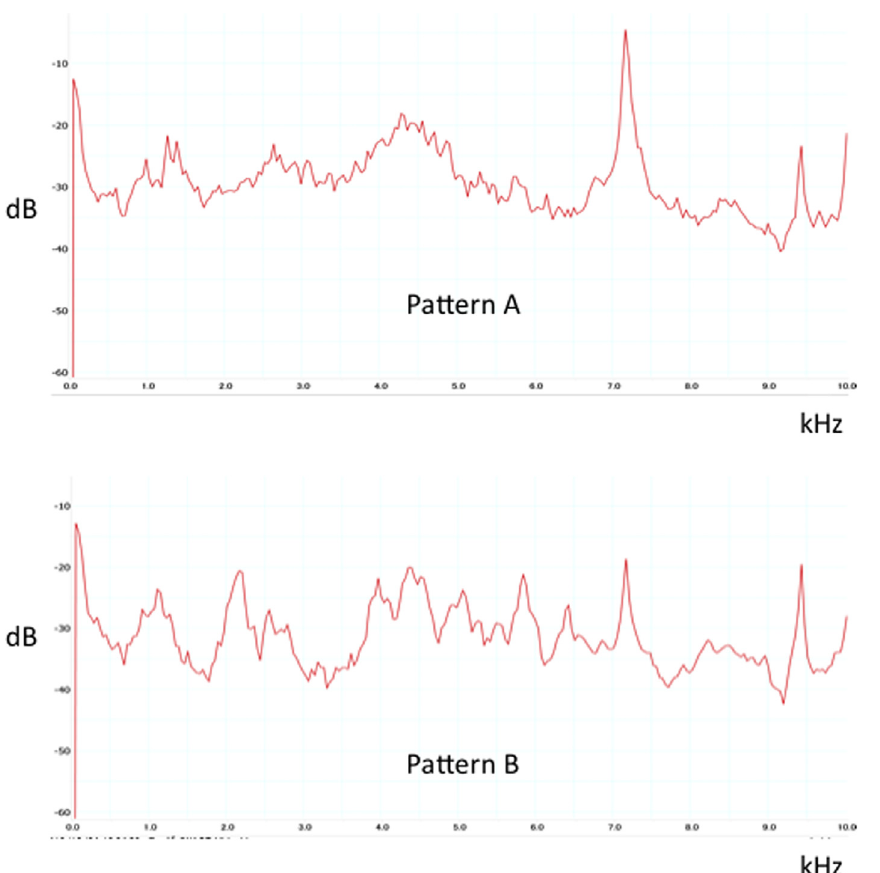
Figure 4. Typical sound data of Patterns A and B. Pattern A, in which frequencies near 7 kHz were more accentuated than other frequencies as the implantation progressed, and Pattern B, in which there was no accentuation of frequencies near 7 kHz through completion of implantation.